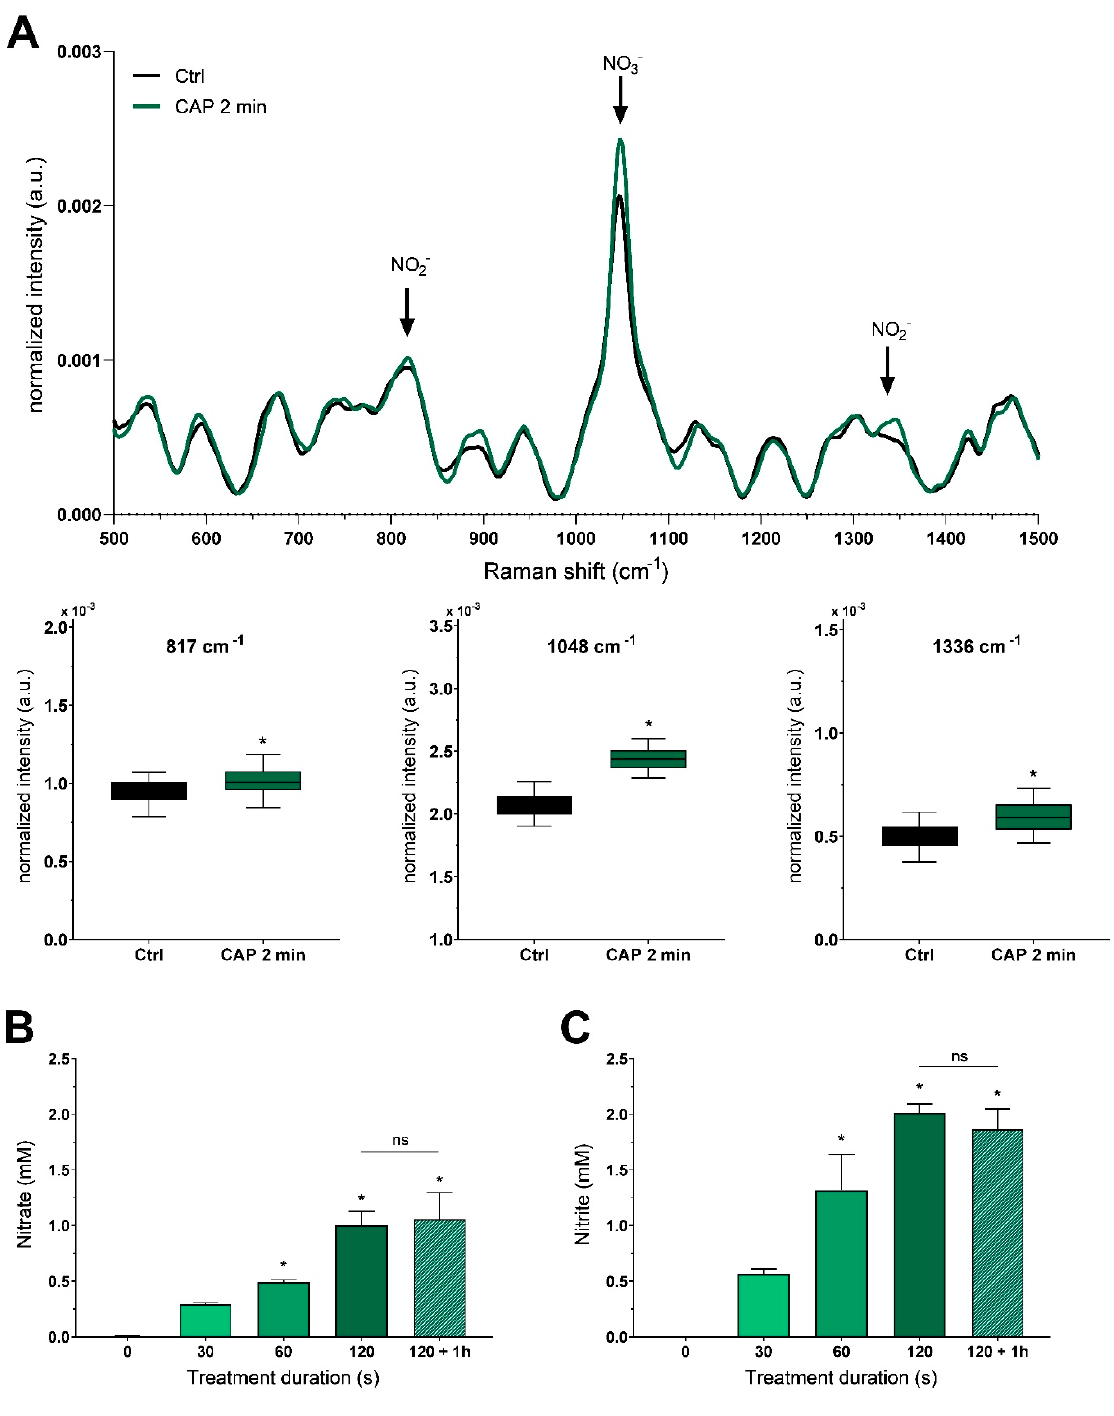
Figure 1. CAP treatment causes the production of nitrate and nitrite. ( A ) Raman spectroscopy of untreated extracellular solution (Ctrl) versus a solution treated with 2 min CAP. Traces are mean only, and box plots are mean with 95% confidence interval (Student’s t -test, n = 300). ( B ) Photometric quantification of nitrate and ( C ) nitrite after different doses of CAP. Stability of these molecules was assessed 1 h after treatment (F (4,10) = 29.31 and F (4,10) = 29.63, both p < 0.0001). Bars are shown as mean ± SEM (ANOVA followed by Tukey’s HSD post-hoc test vs. no treatment, n = 3, *: p <0.05, ns: not significant ( p > 0.05)).